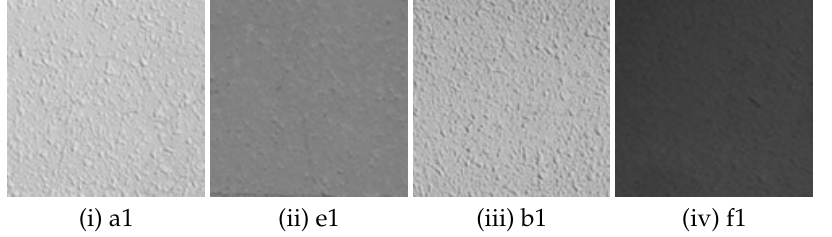
Figure 11. Examples of sub-images extracted from area A, B, E and F captured by a fixed camera.